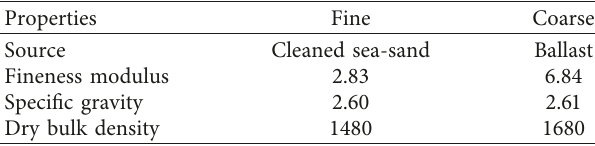
Table 2: Physical properties of normal